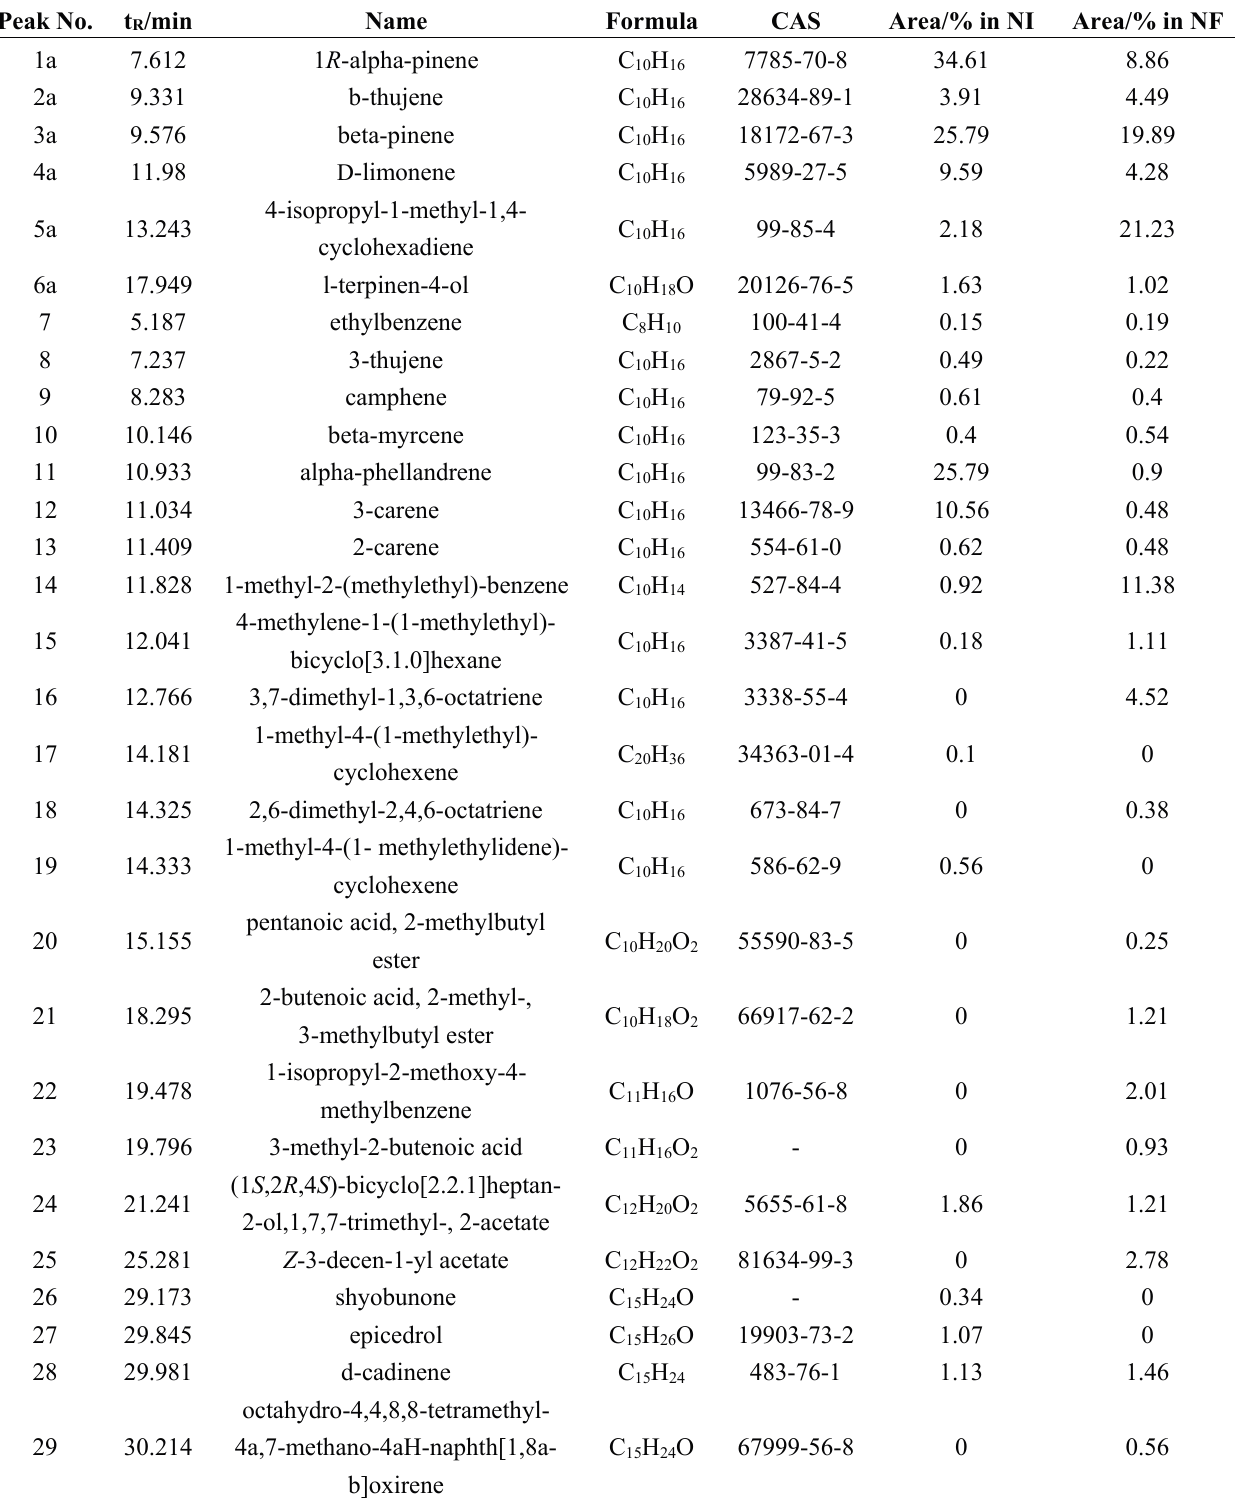
Table 1. Compounds identified by